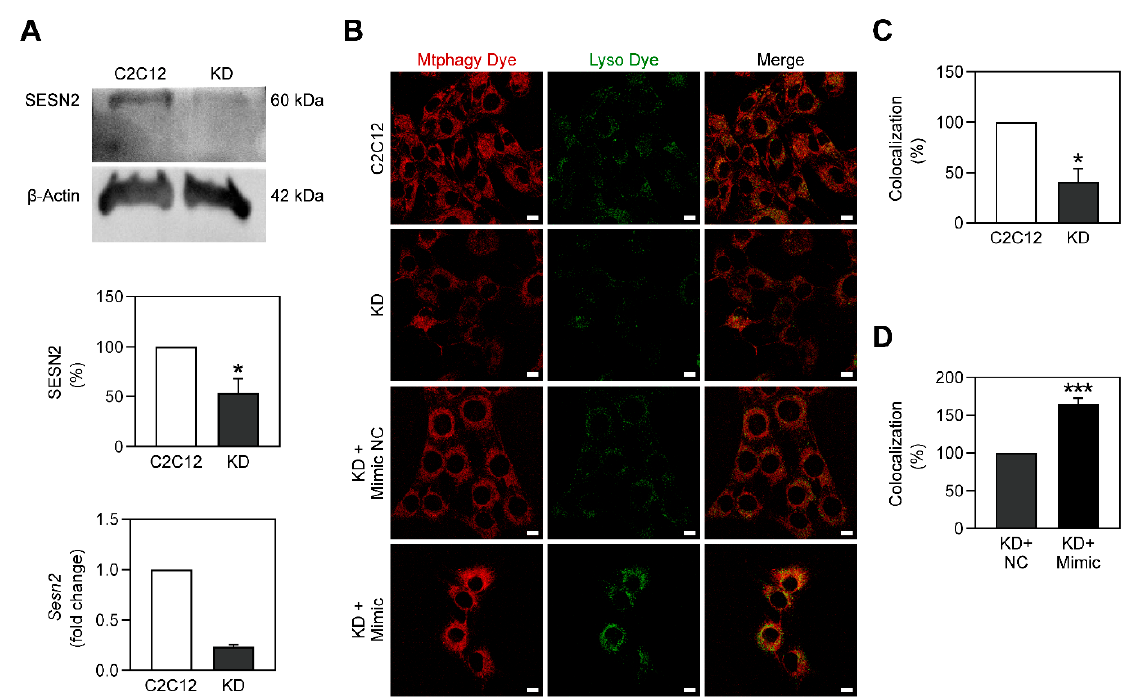
Figure 5. Mitophagy is diminished in Sesn2 KD myoblasts and is rescued with the overexpression of miR-378a-3p. ( A ) Knockdown of Sesn2 in C2C12 myoblasts was confirmed through Western Blot and RT-qPCR. ( B – D ) Mtphagy dye (in red) and Lyso dye (in green) signals as well as their colocalization are decreased when Sesn2 is knocked down. Such parameters are increased when miR-378a-3p is overexpressed. Scale bar, 15 μ m. All data are given as mean ± S.E.M. ( n = 3). * p < 0.04 versus C2C12, *** p = 0.0009 versus KD + NC.